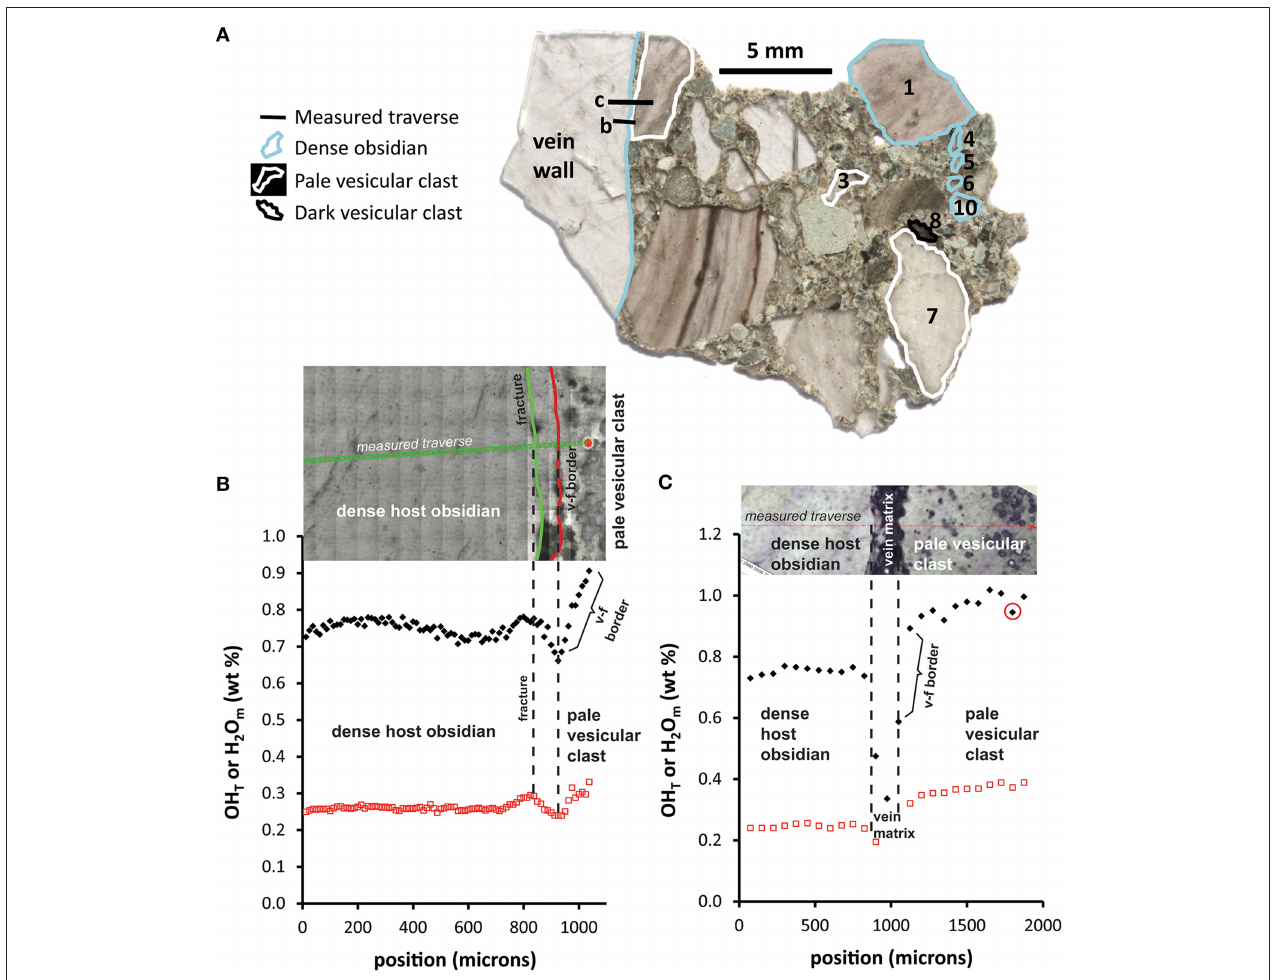
FIGURE 5 | (A) Overview of a large polished wafer (sample BTBcut2A) used in FTIR analysis, indicating the clasts analyzed and the location of the traverses in (B) and (C) . (B) Synchrotron FTIR water concentration profile across the junction between the dense obsidian of the vein wall and a pale vesiculation clast, showing strong depletion in the vesicle-free clast border, from > 0.9wt. % to < 0.7wt. % over 100 microns (sample BTBcut2A). The water-depleted zone corresponds with the ∼ vesicle-free zone (indicated). (C) Benchtop FTIR concentration profile from a different part of the same vein wall-pale vesicular clast junction, showing strong depletion into the vein matrix and higher water concentrations of > 1wt % H 2 O T toward the clast center. In both cases water speciation is magmatic (high OH − /H 2 O m ratios, see Supplementary Datasheet 3), and enrichment dominated by OH − increase, indicating diffusion at magmatic